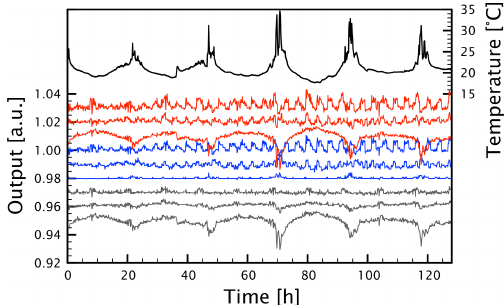
Figure 5. Temperature dependance of the tilt sensor readings. The temperature (in black) and the outputs of the ADXL335 (in red) and ADXL354 (in blue) were logged for 128h. The difference between the two sensors is in gray. For plotting purposes the output of the tilt sensors was normalized to the mean of the first 500 readings of the respective axis and then shifted to 1.03, 1.02, and 1.01 for the ADLX335 x , y , and z axes; 1.00, 0.99, and 0.98 for the ADLX354 x , y , and z axes; and 0.97, 0.96, and 0.95 for the difference between the two sensors ( x , y , and z axes),